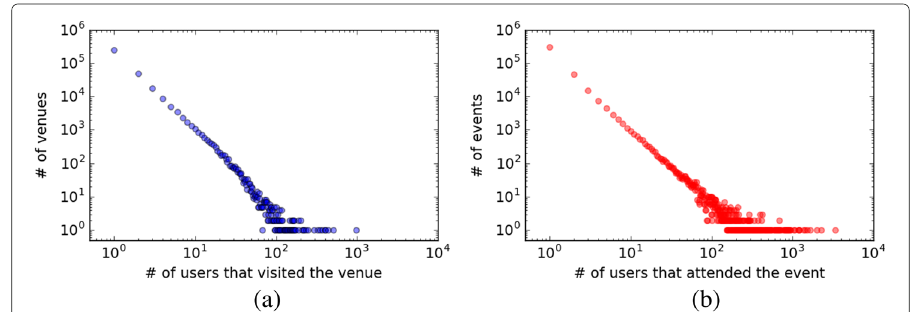
Fig. 2 Aggregate Statistics for the Foursquare (on the left) and Plancast (on the right) dataset: ( a ) and ( b ) depict the number of users that visited (attended) a venue (event)